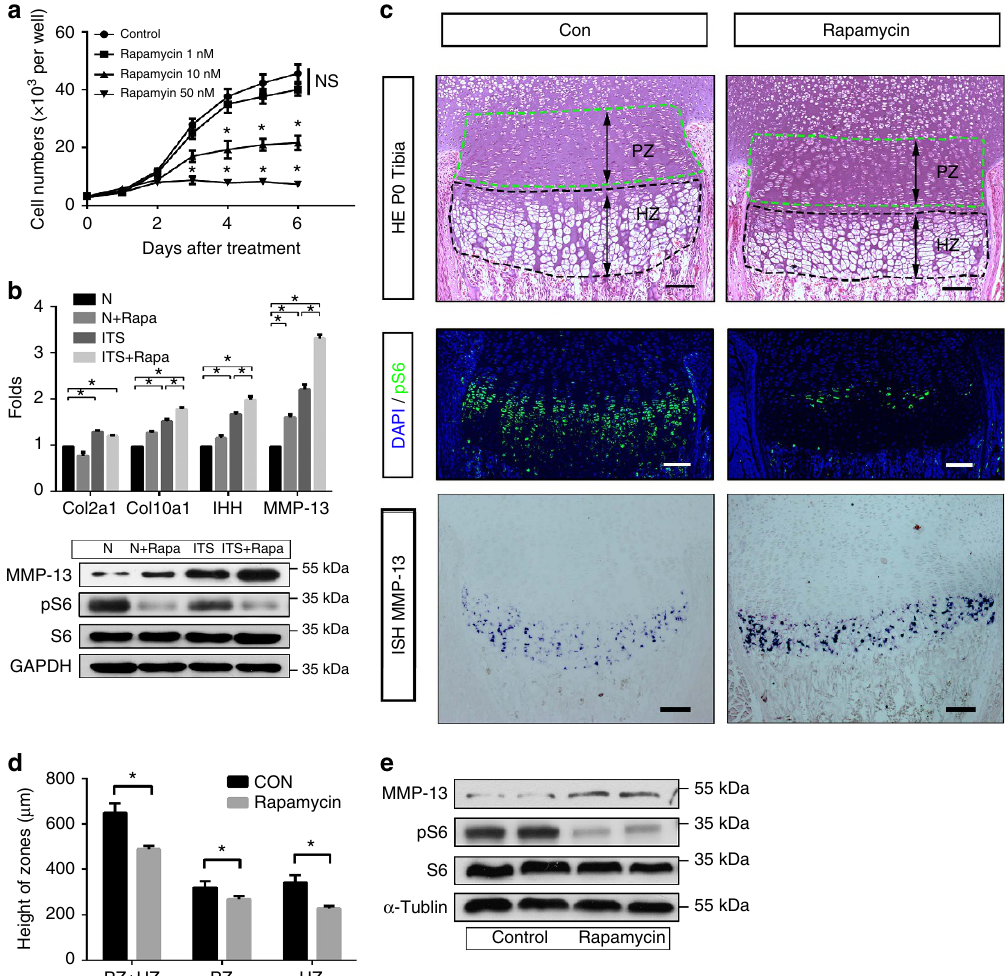
Figure 2 | Inhibition of mTORC1 prevents chondrocyte proliferation while promoting differentiation. ( a ) CCK8 proliferation assay of chondrocytes cultured in normal growth medium or with 1, 10 or 50nM rapamycin treatment. OD 450 values were converted to cell numbers. One-way analysis of variance (ANOVA) and Dunnett’s multiple comparison test; NS, not significant, * P o 0.05, n ¼ 5; Error bars indicate s.d. ( b ) qPCR and western blot analysis of primary chondrocytes cultured in growth medium or ITS medium. Cells were treated with or without rapamycin from day 6 and were harvested on day 14 after confluence. One-way ANOVA and Dunnett’s multiple comparison test, * P o 0.05, n Z 3; Error bars indicate s.d. ( c ) HE staining, pS6 immunofluorescence and MMP-13 in situ mRNA analysis of Tibia sections of mice at P0 whose maternal mice receiving a daily intraperitoneal injection of rapamycin (1.5mgkg (cid:2) 1 per day) or 0.9% saline for 3 days before sacrifice. Scale bar, 100 m m. PZ, proliferative chondrocyte zone; HZ, hypertrophic chondrocyte zone. ( d ) Quantification of Tibia PZ and HZ length in P0 mice receiving rapamycin. Student’s t -test, * P o 0.05, n Z 3; Error bars indicate s.d. ( e ) Western blot of pure cartilage tissues harvested from long bone mice receiving birth (Supplementary Fig. 3a,b). The femur, humerus, tibia and spinal column of TSC1CKO mice were 20–25% shorter than those of control mice (Fig. 3c). The majority of TSC1CKO mice died before 15 weeks of age, possibly as a result of pneumonia. X-rays revealed significant pathological thoracic lordosis with severe rib wavy-like dysplasia in 3-month-old TSC1CKO mice, resulting in a considerably smaller thoracic volume relative to that in control littermates (Supplementary Fig. 3c,d). Histological analysis of humerus and tibia from P0, 2, 4 and 8-week-old mice showed reduced hypertrophic chondrocytes at P0, and subsequent postnatal progressive expansion of chondrocytes at all stages in TSC1CKO mice, which was most evident in hypertrophic chondrocytes, resulting in a significantly thicker growth plate compared to control mice (Fig. 3d,e). Based on these results, we propose that loss of TSC1 delays postnatal endochon- dral bone development and causes chondrodysplasia and dwarfness in mice.